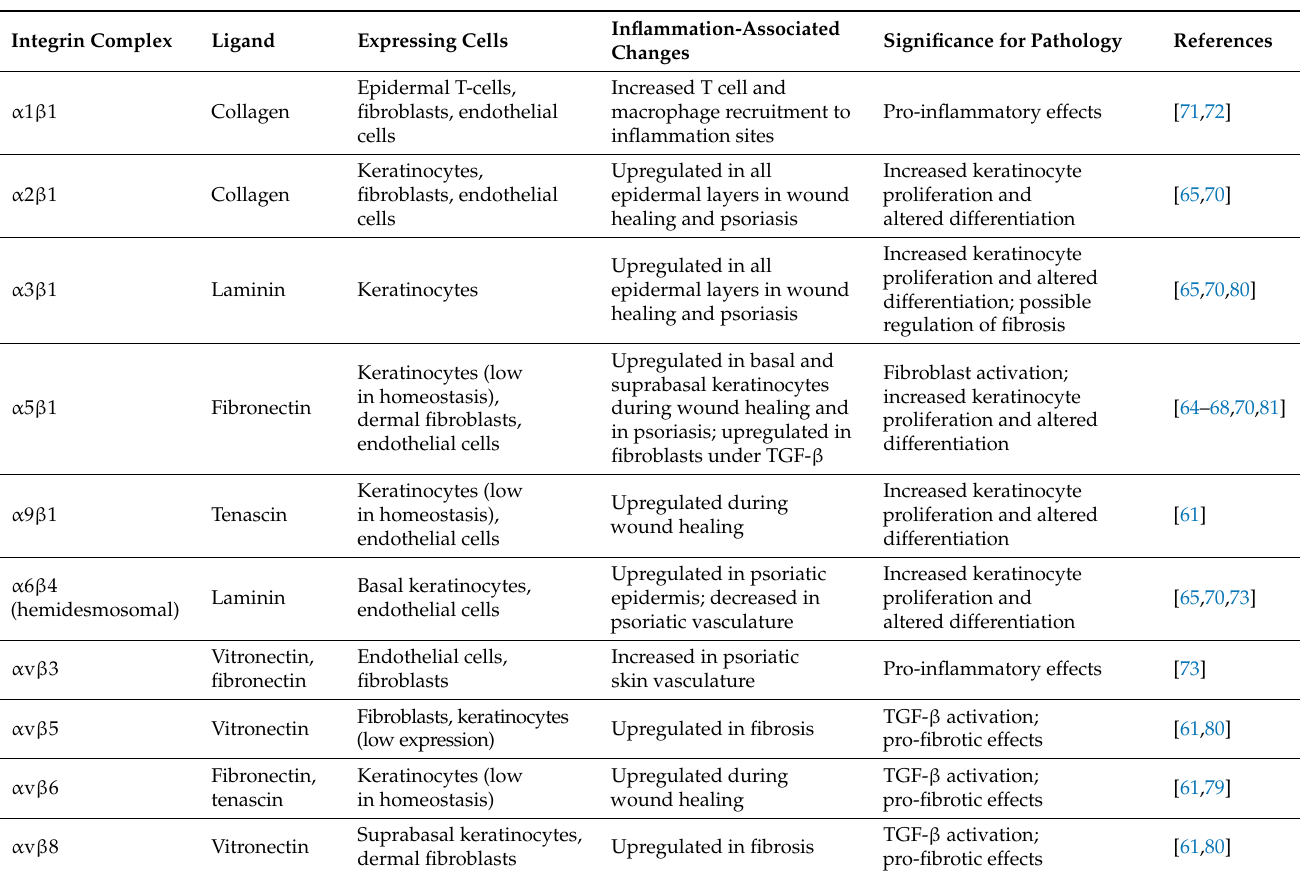
Table 2. Integrin alterations during skin